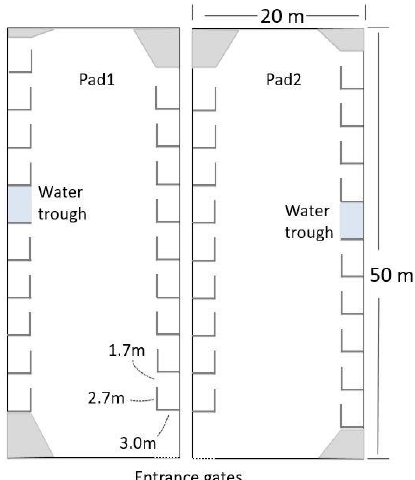
Figure 1. Pads were next to each other. The hides were opened and closed on each pad on alternating days (Phase 1, 22 d) and left open on both pads (Phase 2, 18 d). Grey indicates corners that were walled